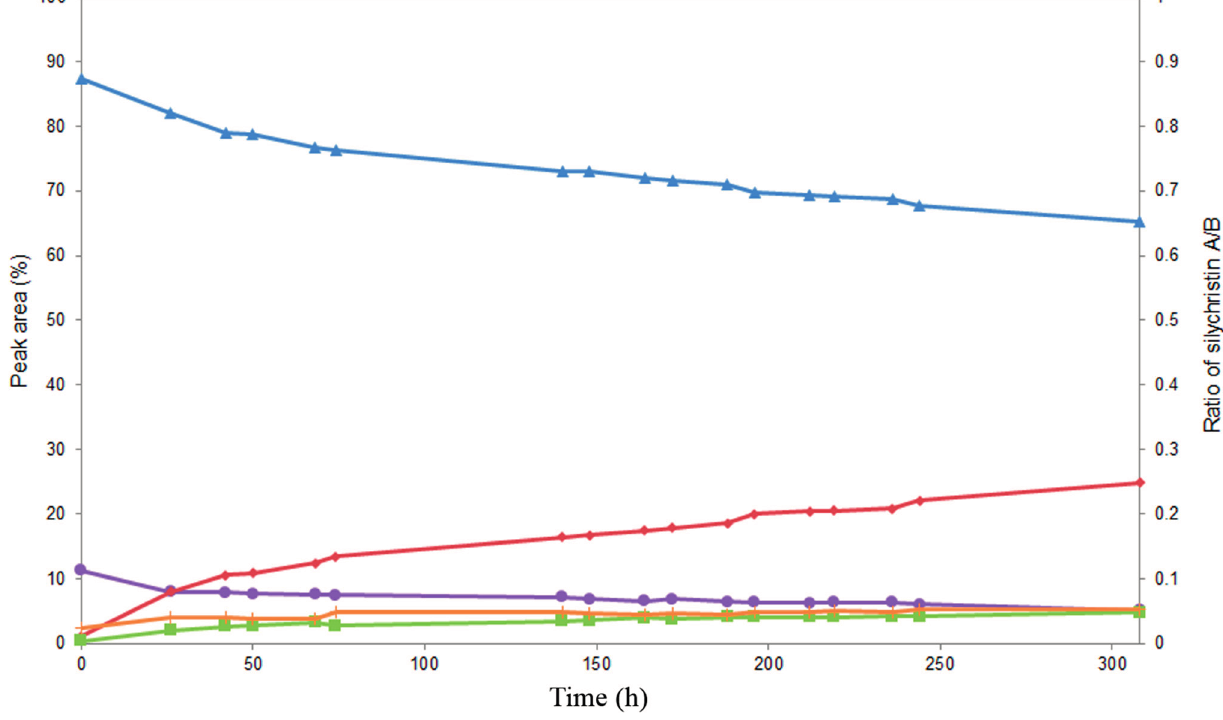
Figure 3. Time course study of Novozym 435 catalyzed deacetylation of 22- O -acetyl silychristins A ( ▲ ) and B (  ) yielding the corresponding silychristin A (  ) and silychristin B (  ); (+) ratio of peak areas of silychristin A:silychristin B (secondary axis y ; please note that this axis has a different